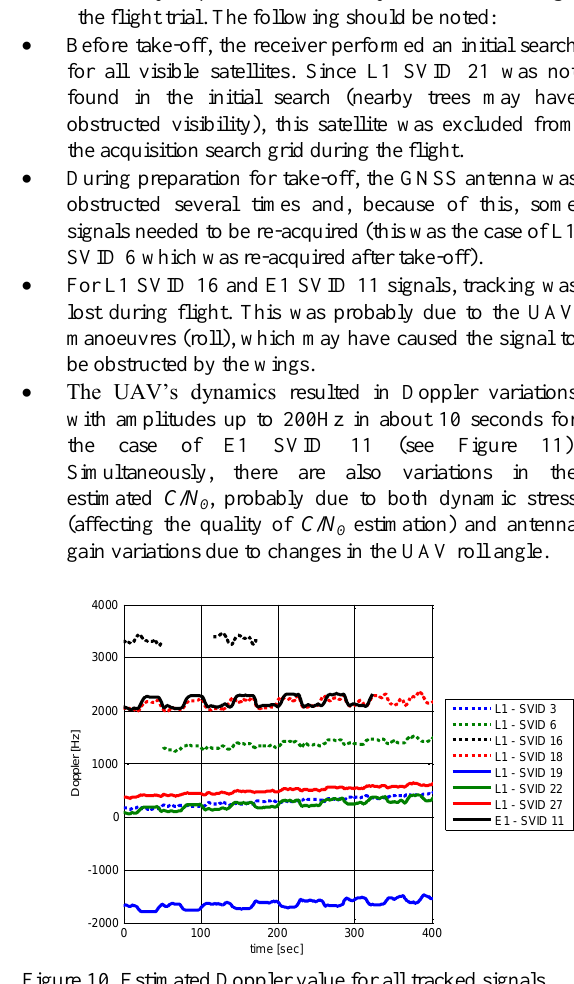
Figure 10. Estimated Doppler value for all tracked signals.